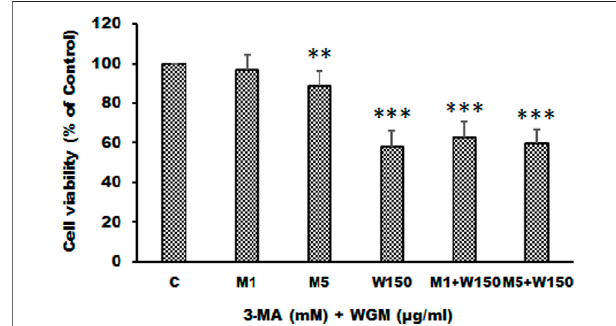
FIGURE 5 | The effects of 3-MA on WGM extracts-induced cell death of Hep3B cells. Cells were pretreated with 1 or 5 mM 3-MA (M1 and M5) for 1 h and then treated with0.1% DMSO (C) or 150 μ g/mlWGM extracts (W150) for 24 h. The medium was not changed in the whole process of the experiment.Aftertreatment,theviablecellsweremeasuredbyMTTassayand the fraction of viable cells were calculated by de fi ning the absorption of cells without treatment of WGM extracts as 100%. Data represent the mean percentage of control ±S.D. ( n = 3). ** p < 0.01, *** p < 0.001 compared to the control values.